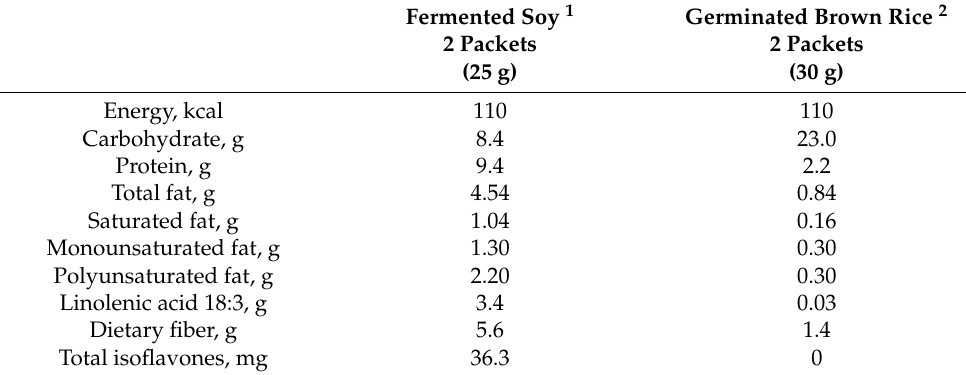
Table 1. Nutrient composition of study